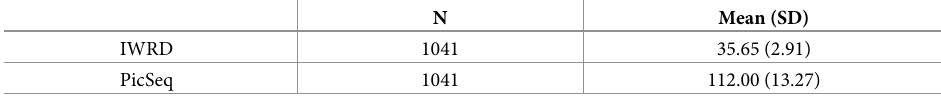
Table 2. Descriptive statistics of episodic memory tests.